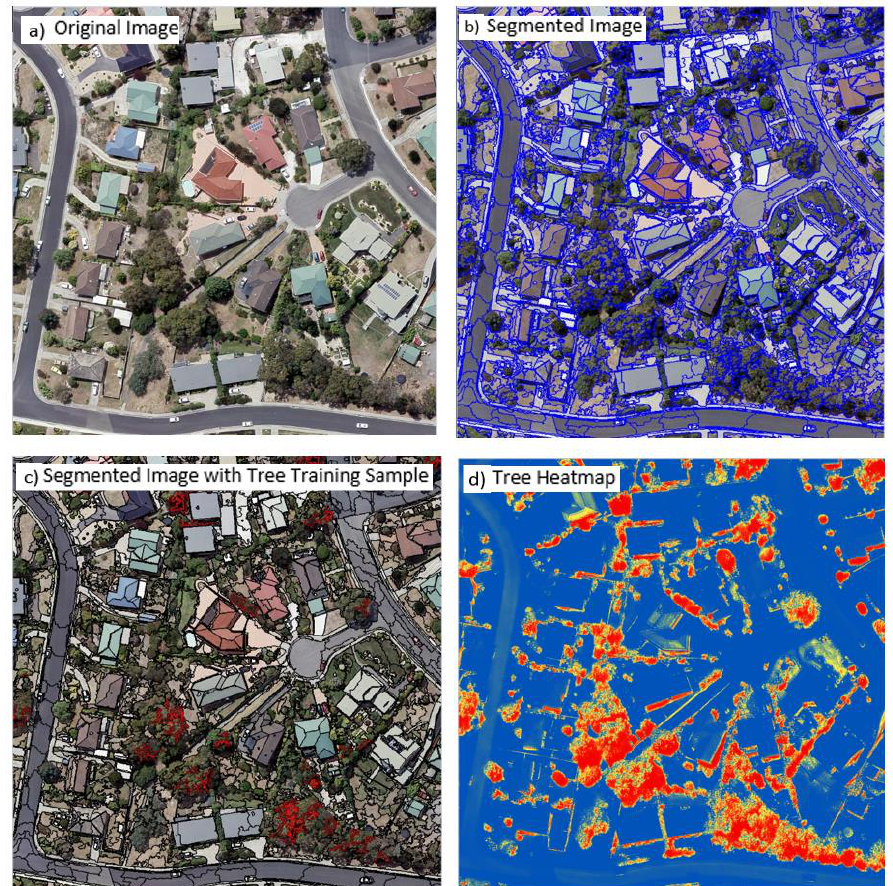
Figure 9. From left to right: ( a ) sample of original 2015 aerial image, ( b ) segmented image, ( c ) segmented image with tree training samples (red polygon) and ( d ) tree heatmap (the values close to 1 (red) indicate the high likelihood of trees, and those close to 0 (blue) indicate a low likelihood of trees).